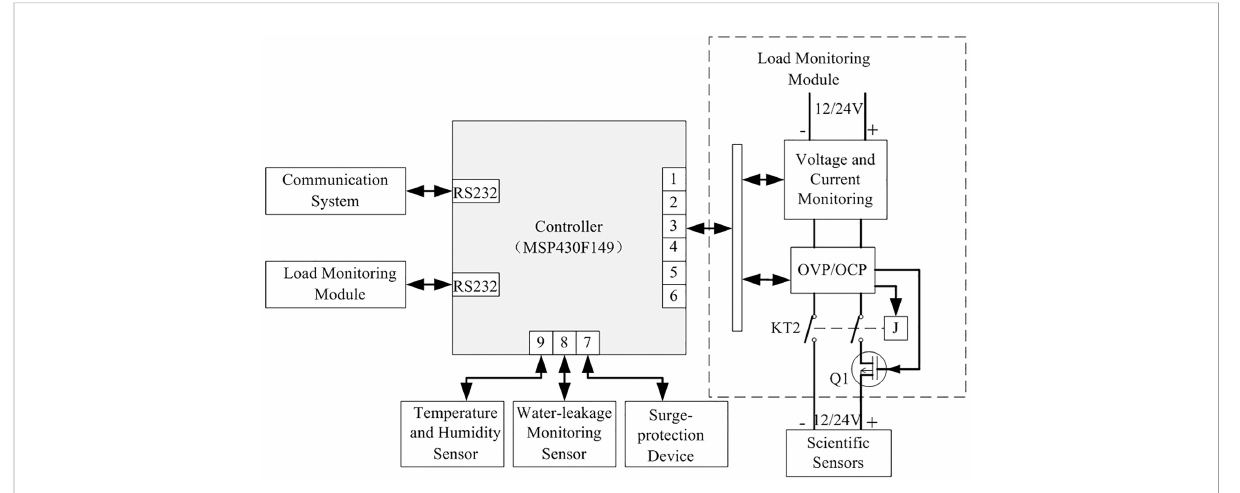
FIGURE 5 Block diagram of state monitoring and control system.